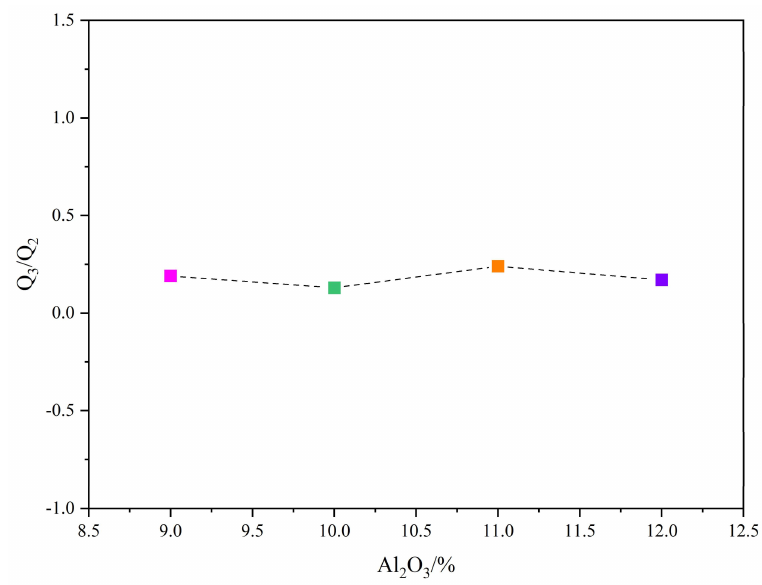
Figure 12. Degree of polymerization of the glassy phase samples with different Al 2 O 3